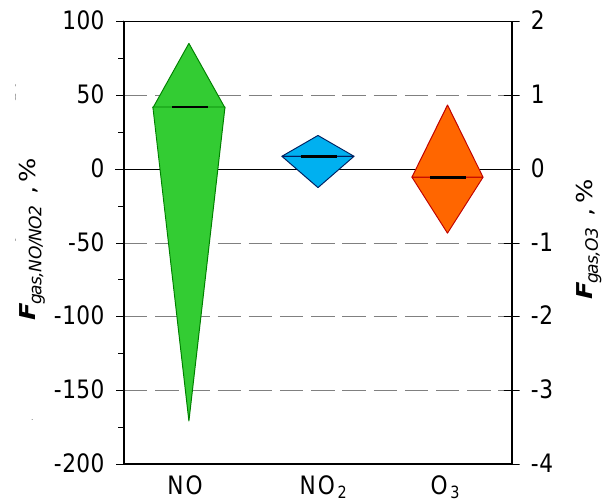
Fig. 16. Relative contribution of gas-phase flux densities F gas, i to the exchange flux densities F ex, i for NO (green diamond), NO 2 (blue diamond) and O 3 (orange diamond). Results are from the field experiment, restricted to one selected data category (see Sect. 4.4.2). The apexes of the diamonds represented the upper (75 %) and the lower (25 %) quantile and the black dash in the middle of the diamonds the median. F gas,NO and F gas,NO2 were applied to the left y-axis and F gas,O3 to the right y-axis.